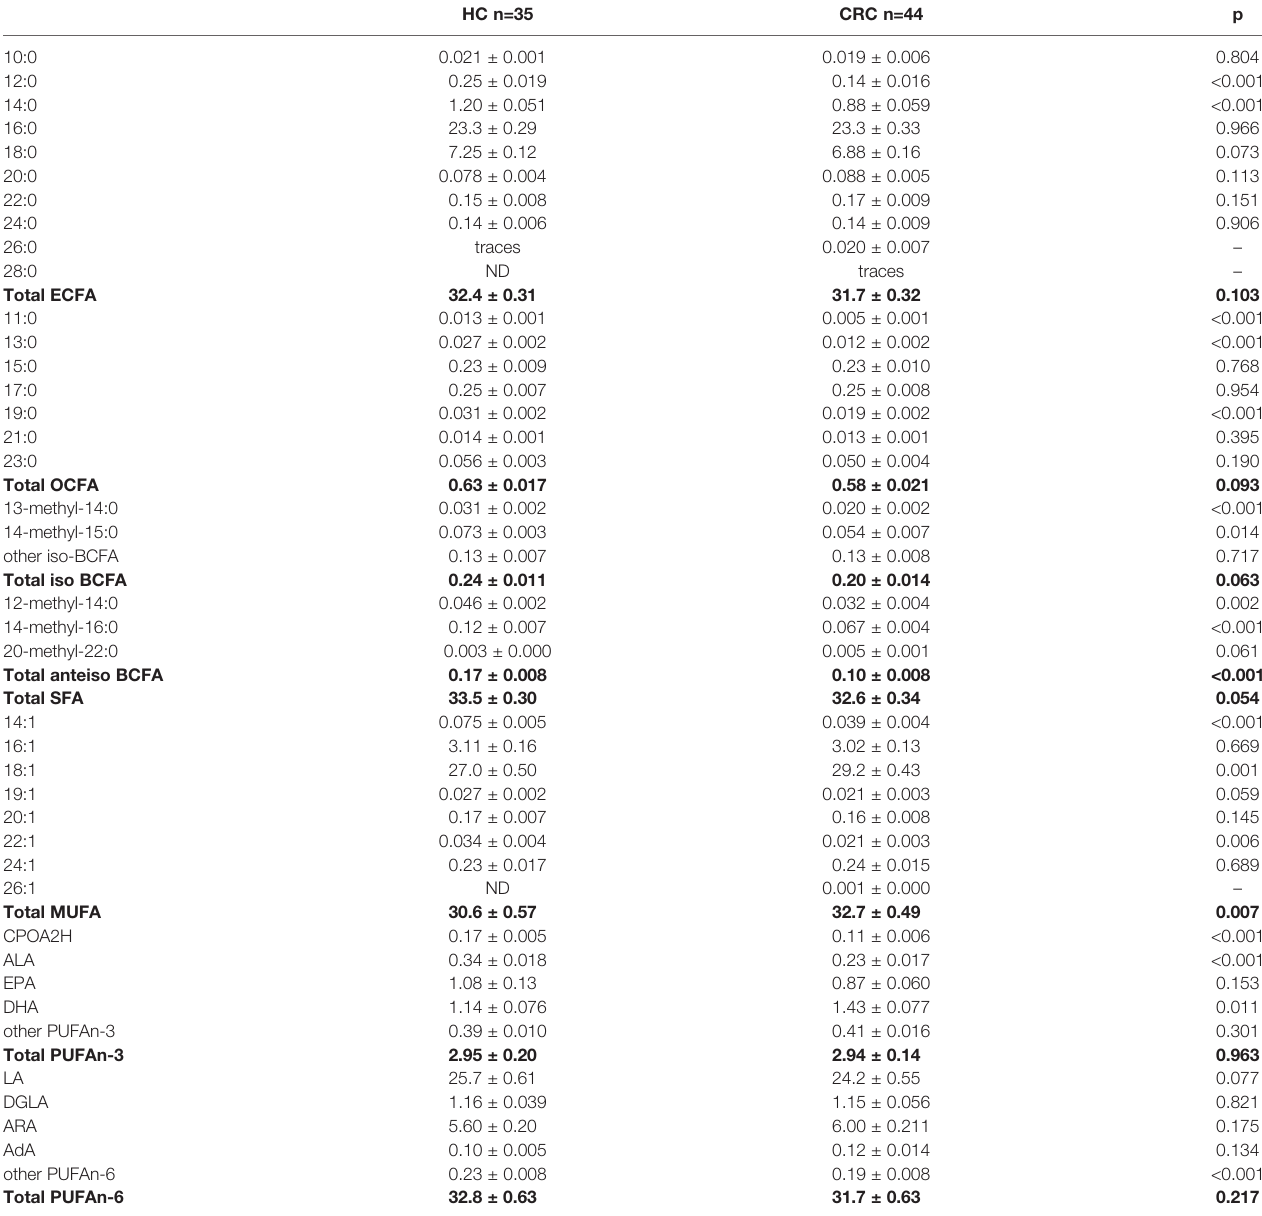
TABLE 3 | Fatty acids pro fi le (%) in serum of healthy controls (HC) and CRC patients.